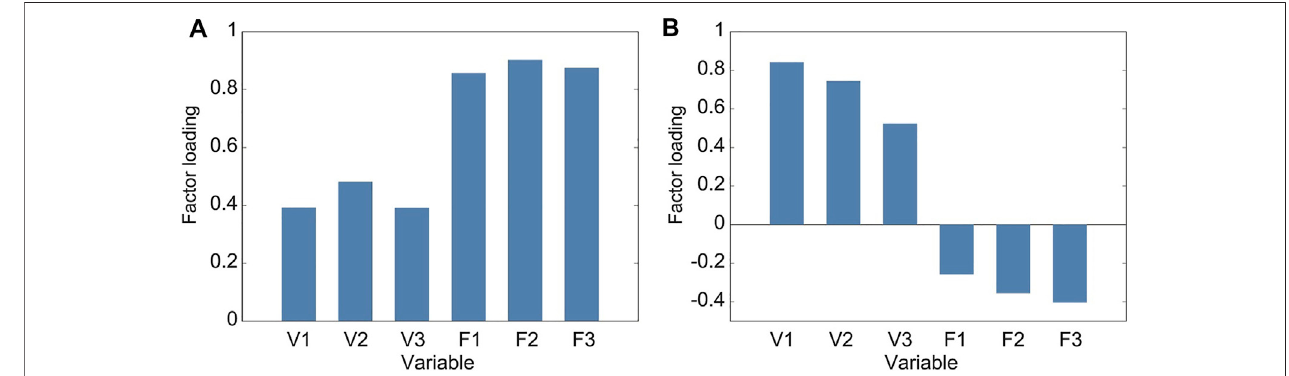
FIGURE4| Factorloadingsofprincipalcomponentsfromgaitspatialfeatures.Loadingisthepositiveornegativecorrelationbetweenaprincipalcomponentanda variable. (A) Factor loadings of the fi rst principal component, which is strongly and positively correlated to variables in the forward displacement (F1 to F3) and hence describes this displacement in the foot trajectory. (B) Factor loadings of the second principal component, which is strongly and positively correlated to variables in the vertical displacement (V1 to V3) and hence describes this displacement in the foot trajectory.